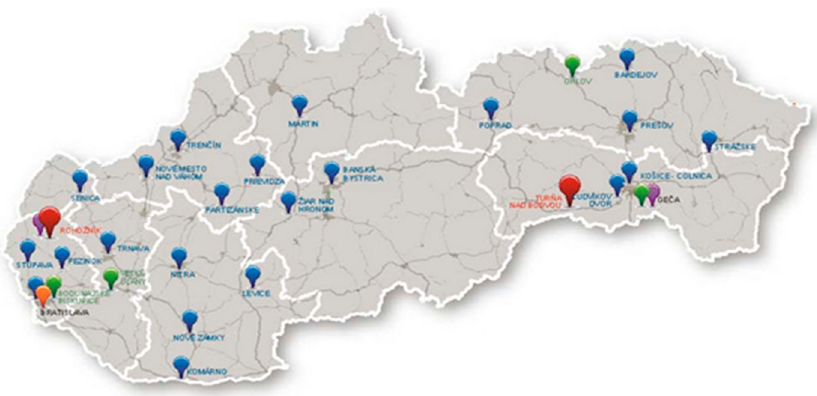
Figure 1. Cement companies in Slovakia. Source: author’s own